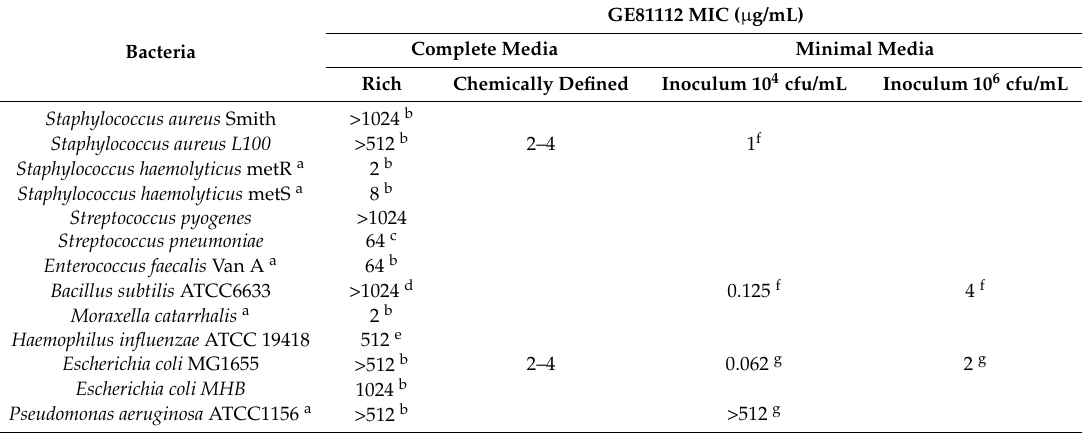
Table 1. Antimicrobial activity (MIC) of GE81112 on various Gram-positive and Gram-negative bacteria in growth media.